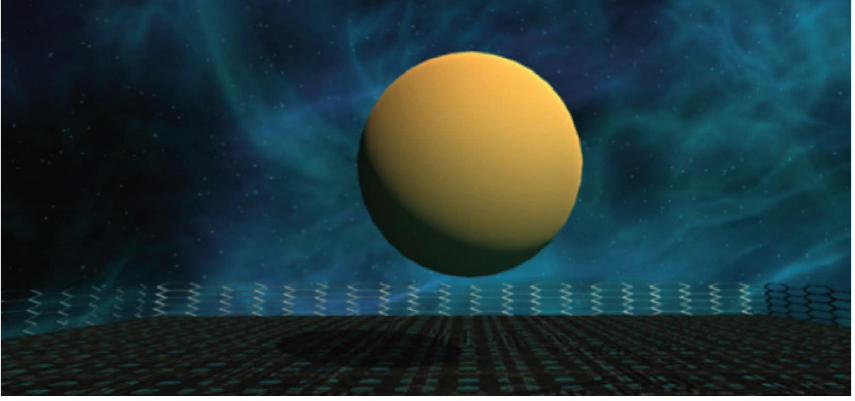
Figure 1: Experience with the SOTER VR application. Table 3: Descriptive analysis of the three study variables: PAIN, HR, and GSR, and two transformed variables: PAIN INCREMENT and PAIN